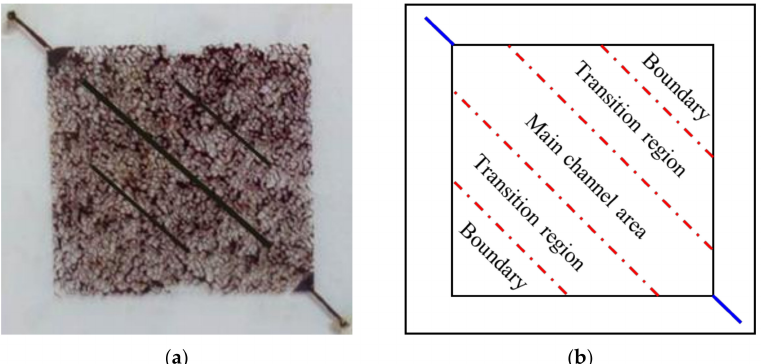
Figure 5. Photograph ( a ) of the etched glass micromodel saturated with crude oil, and diagrammatic sketch ( b ) of its regional division.